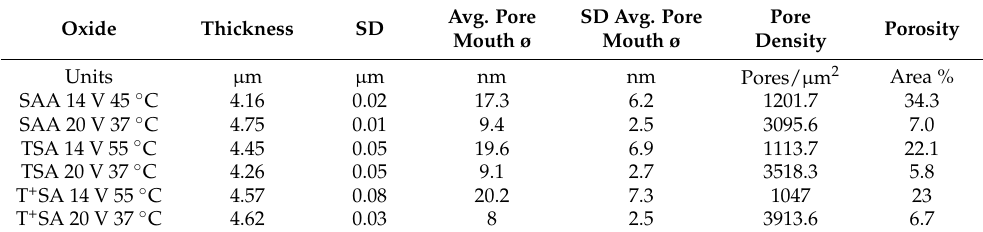
Oxide Table 2. Summary of morphological features measured from FE-SEM imaging.